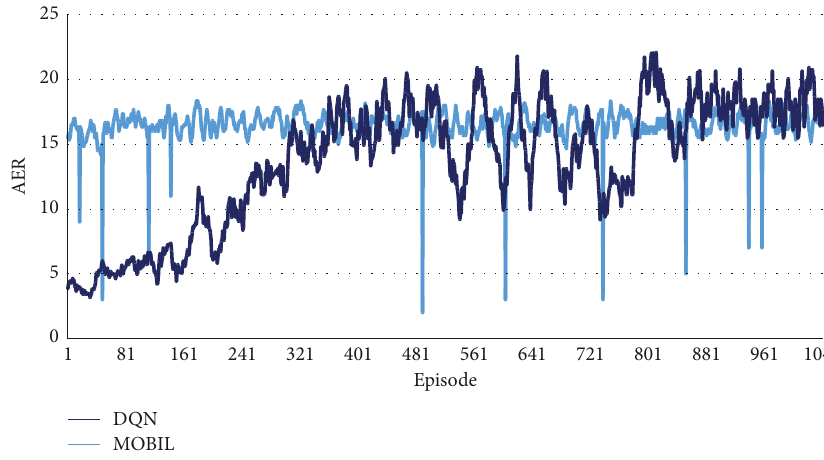
Figure 7: Comparison of AER between DQN and